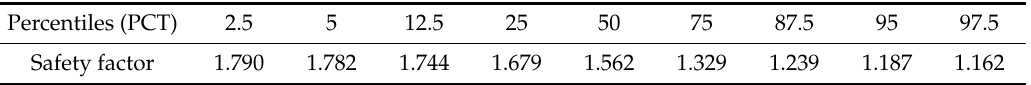
Table 3. Safety factors for different percentiles of the